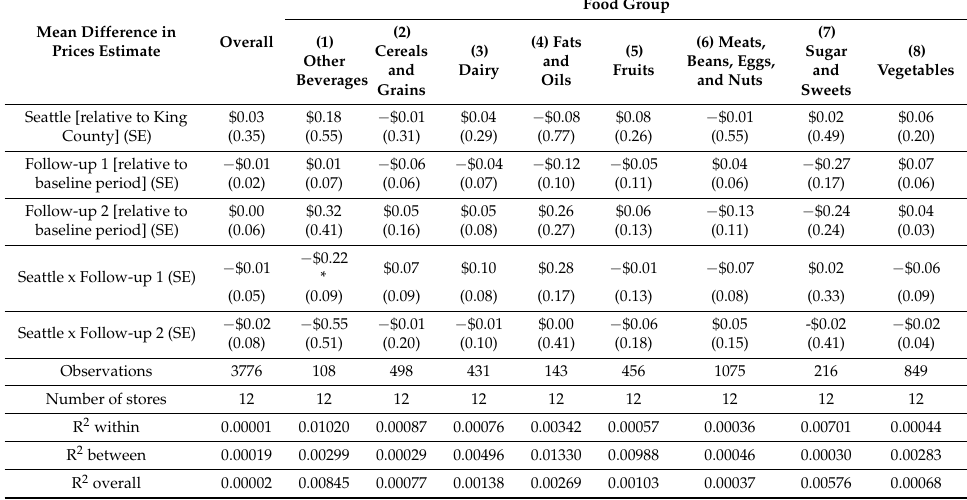
Table 3. Overall and food group stratified linear difference-in-differences model results for the mean change in item-level price across Seattle and King County stores and time, from March 2015 to May 2016.